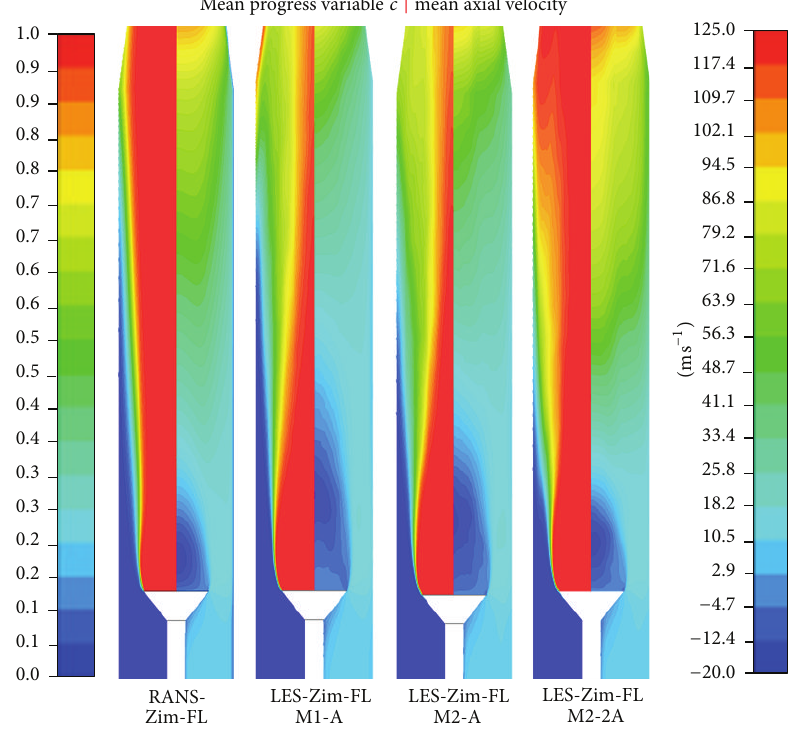
Figure 10: Mean progress variable and axial velocity contours (longitudinal